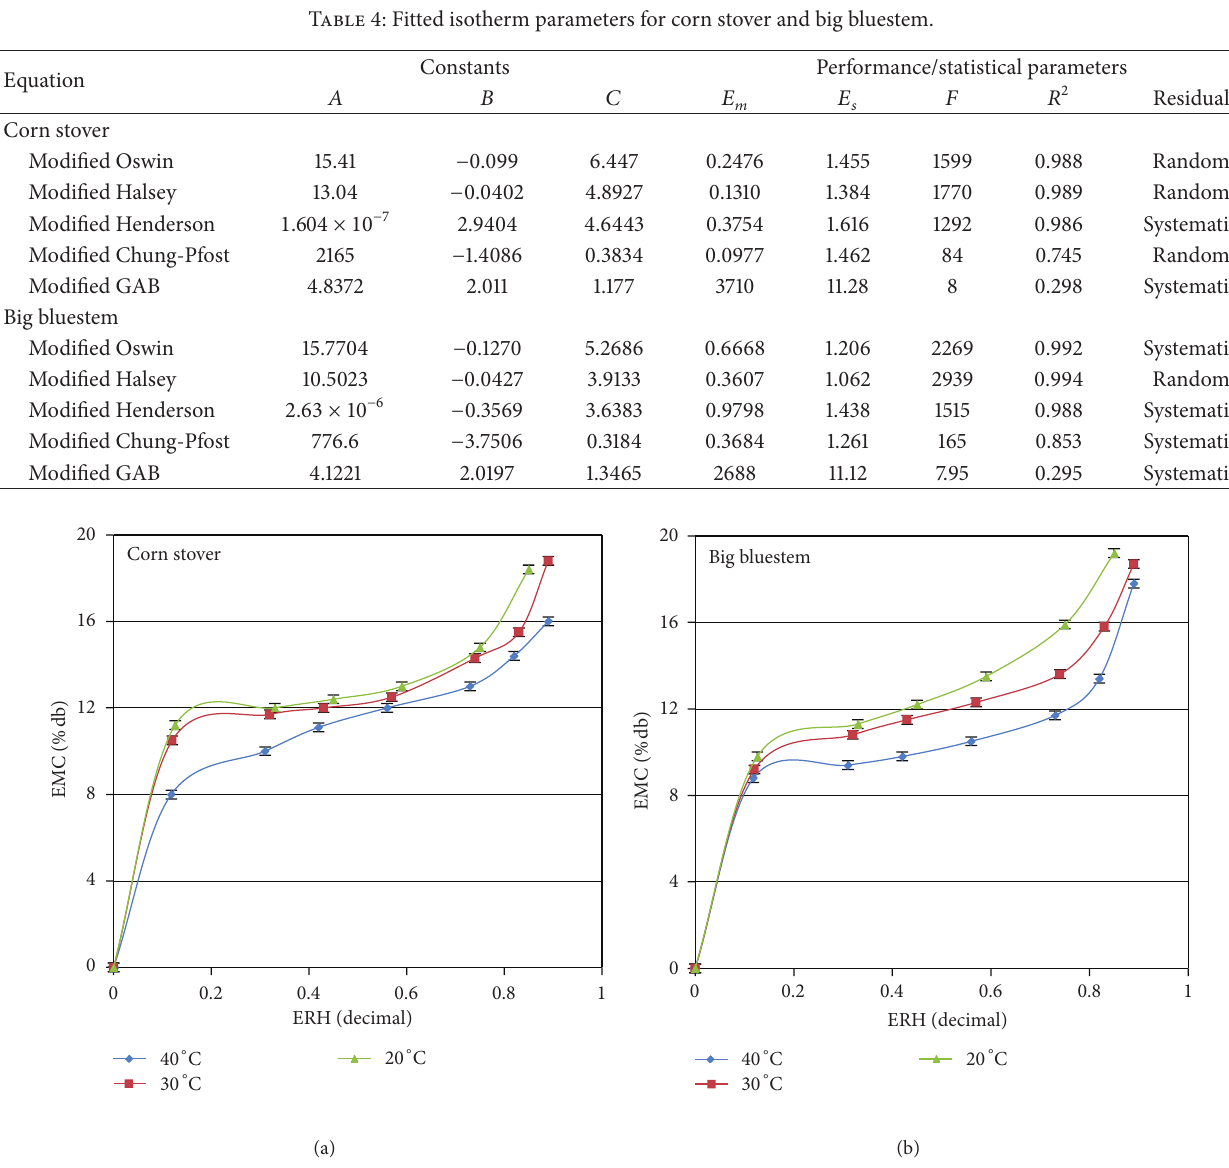
Figure 1: Moisture sorption of corn stover and big bluestem at indicated relative humidities and